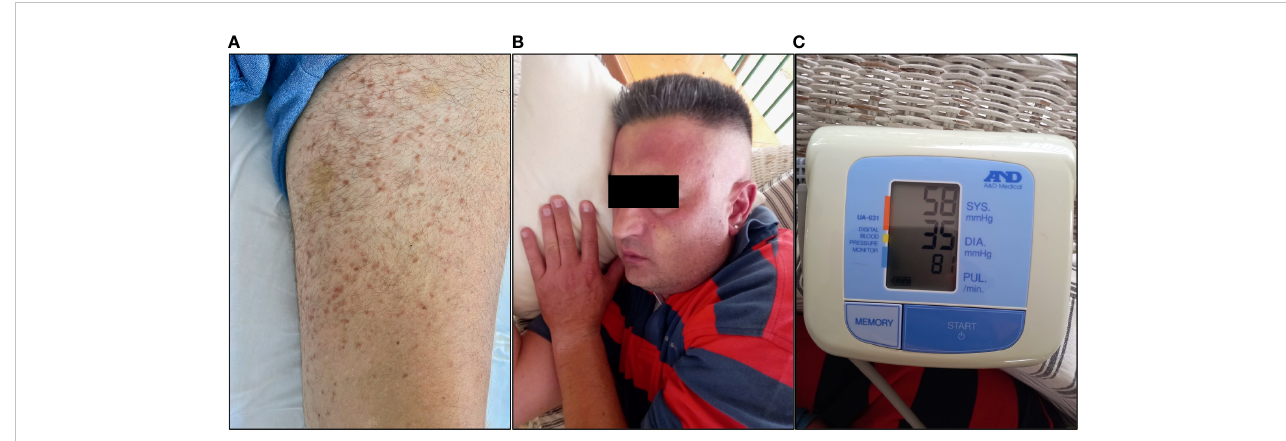
FIGURE 2 Photographs showing (A) the chronic urticarial rash, (B) facial fl ushing and (C) profound hypotension during an anaphylaxis episode in our patient (Courtesy of K.T.; written informed consent was obtained from the individual shown).